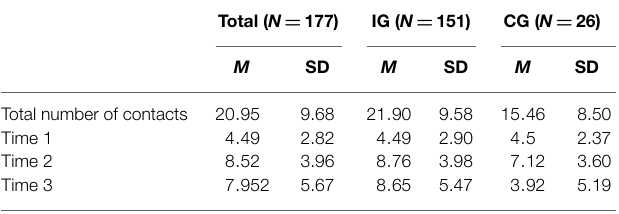
TABLE 6 | Descriptive statistics for the number and temporal distribution of postpartum midwife contacts